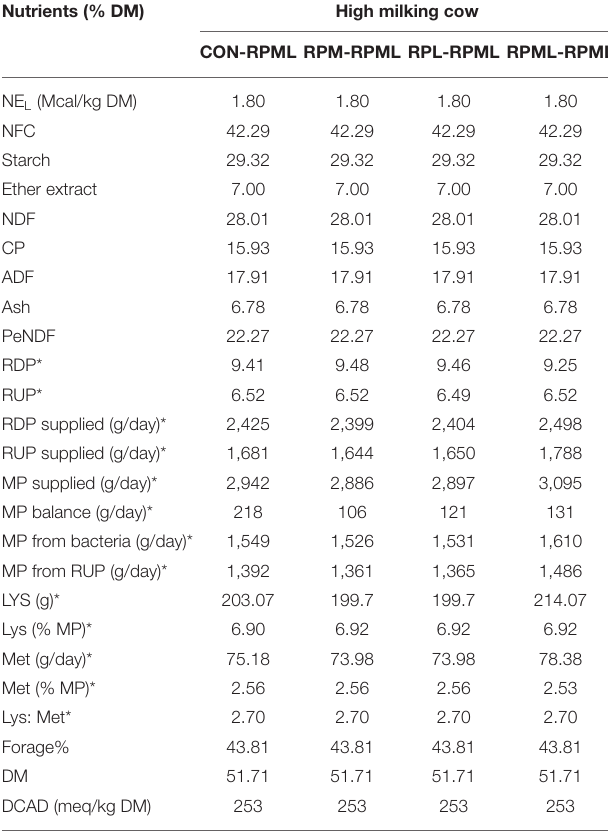
TABLE 1 | Ingredients of the total mixed ration (TMR) fed to Holstein dairy cows during the high milking periods 1 . Nutrients (% DM) High milking cow